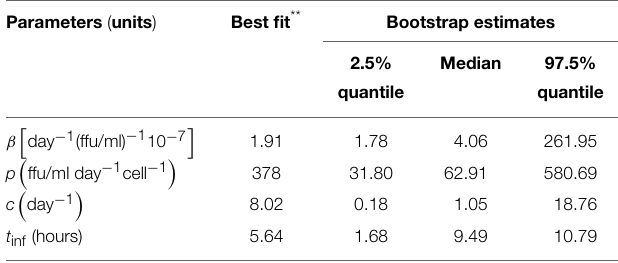
TABLE 1 | Estimates of infection parameters *